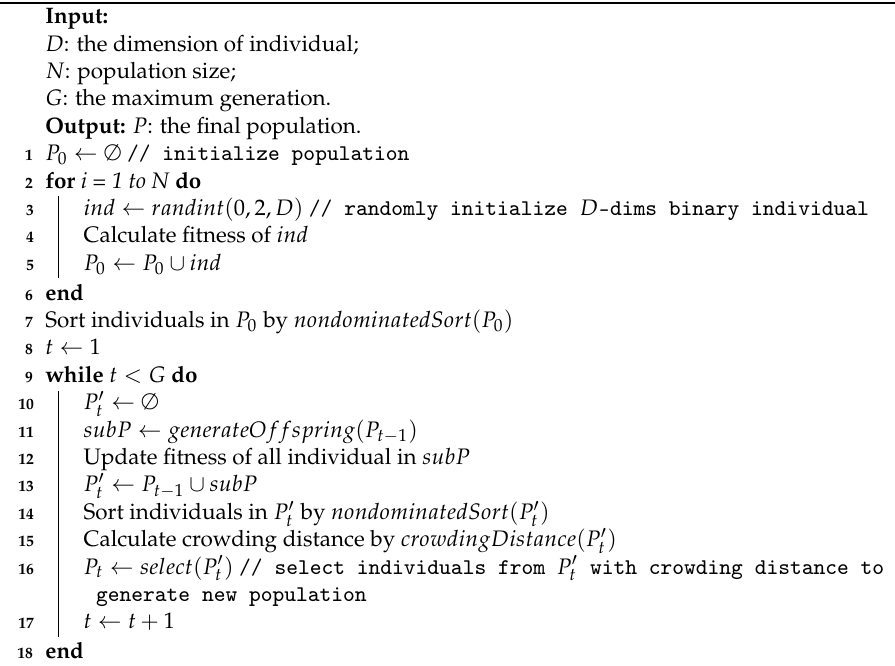
Algorithm 2: Pseudocode of evolutionary multi-objective filter